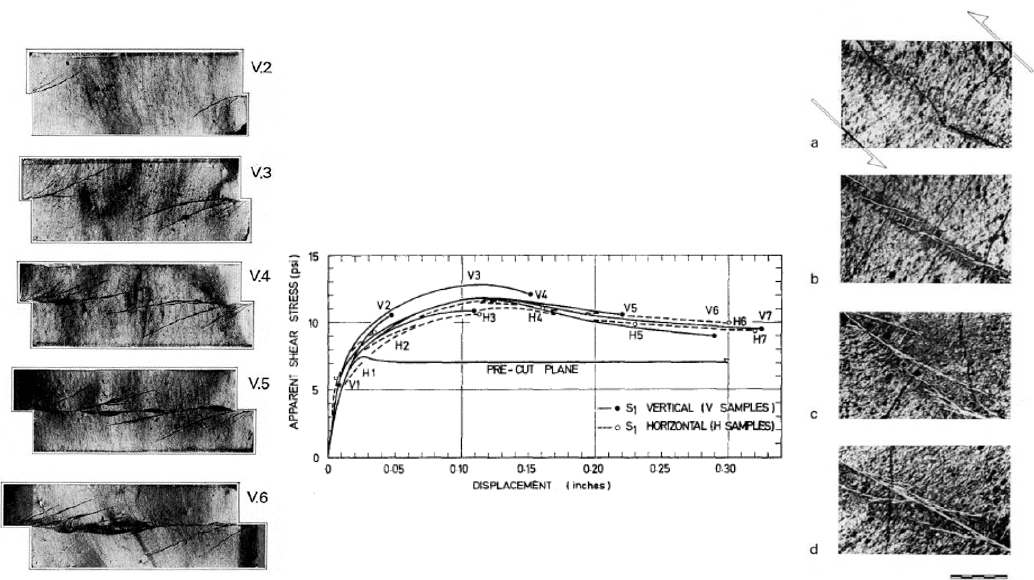
Fig. 2: Sequence of kaolin clay structures sheared normal to original clay fabric (left) and sequential development of discontinuity with arrow indicates direction of shearing (right) (Morgenstern & Tchalenko, 1967)